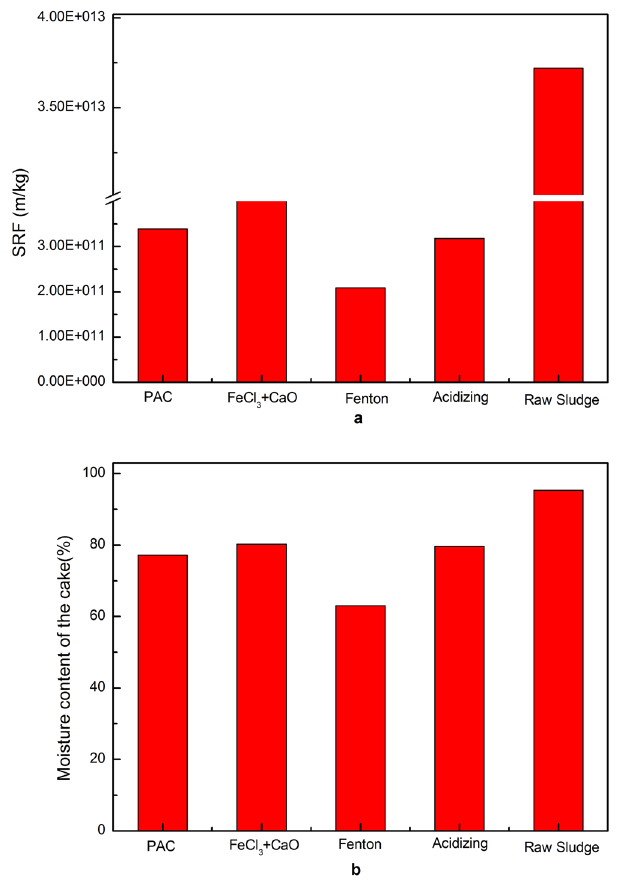
Figure 1. Effect of four inorganic coagulants on SRF ( a ) and moisture content of the cake ( b ).